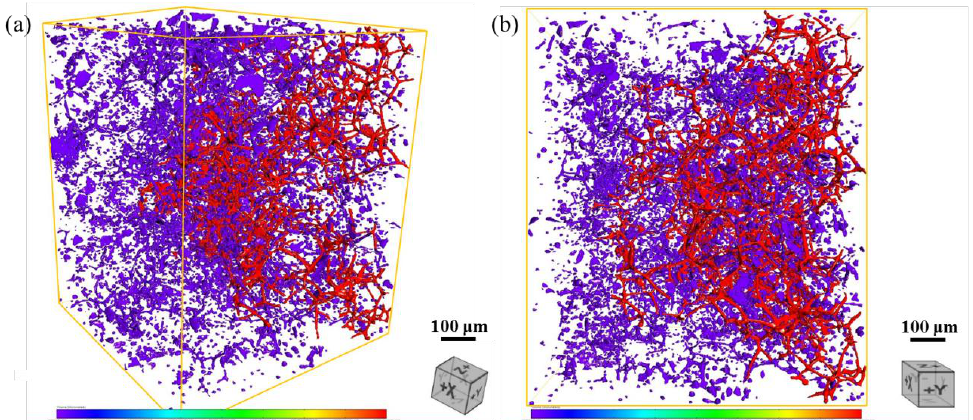
Figure 8. Three-dimensional topographical characteristics of the Ca 2 Mg 6 Zn 3 secondary phase in the ZM-0.3Ca alloy: ( a ) perspective view, ( b ) sectional view of the perpendicular Y axle.